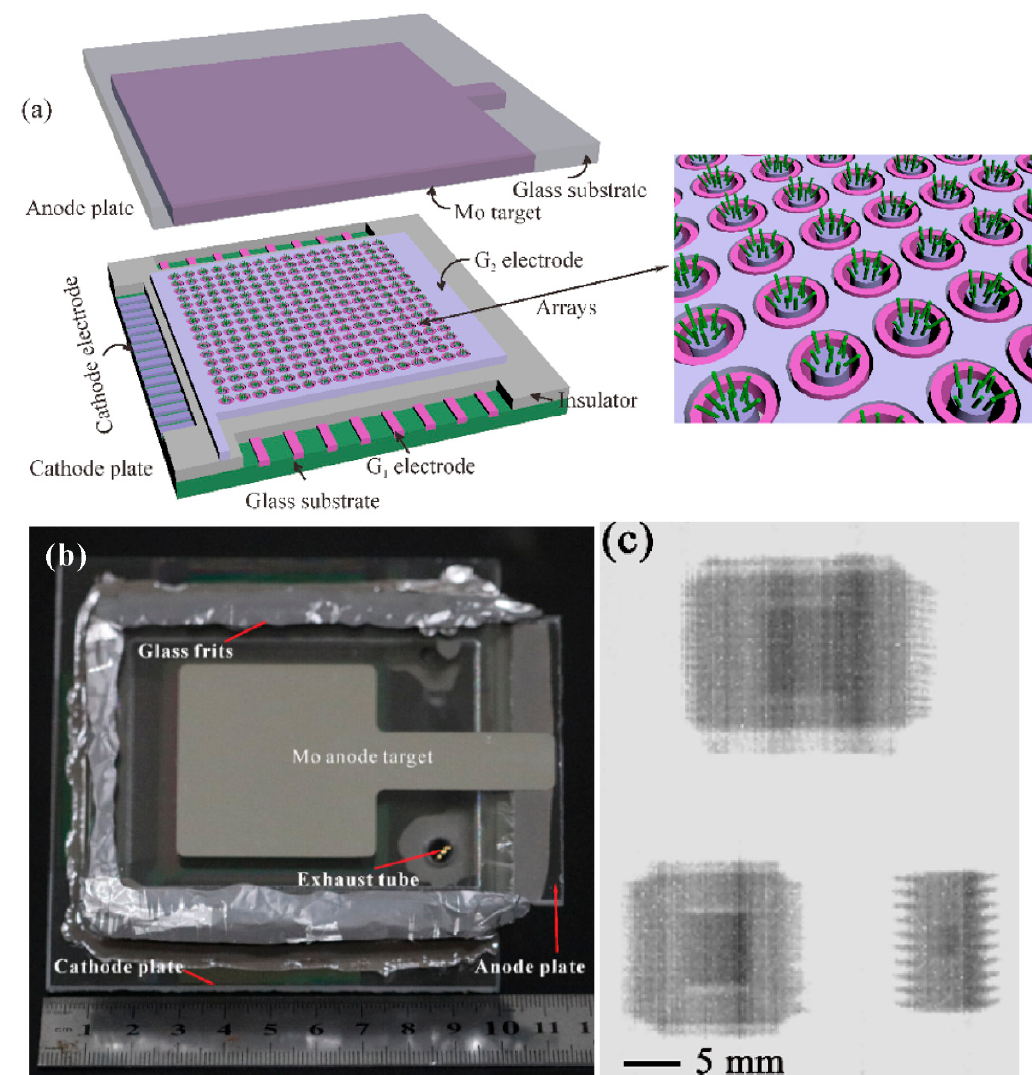
Figure 35. Addressable flat panel X-ray source based on ZnO nanowires. Schematic diagram ( a ) and optical image ( b ) of the device. ( c ) X-ray image of the integrated circuit chips. Reproduced from [111], with the permission of AIP Publishing, 2021.